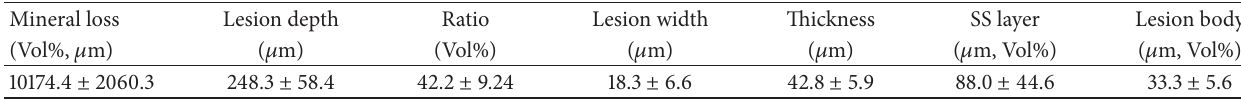
Table 1: Summary for all TMR parameters (mean ± SD).